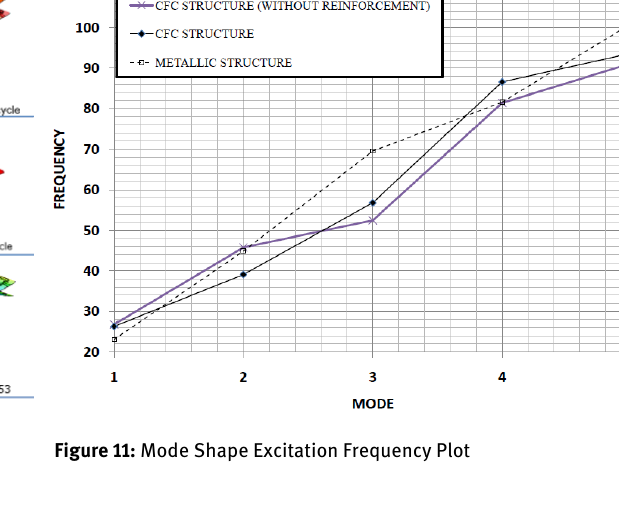
Figure 11: Mode Shape Excitation Frequency